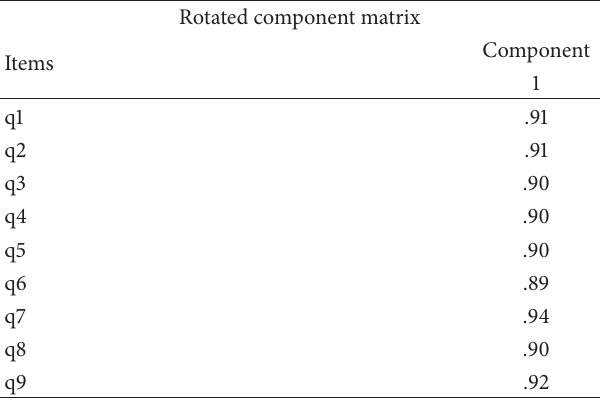
Table 3: Factor Analysis-Principal Component Analysis with dis- tribution of varimax rotation of PDRQ-9